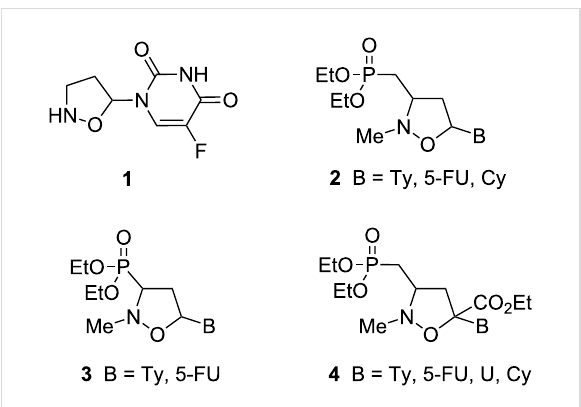
Figure 1: 2’-Oxa-3’-aza-modified nucleosides and 2’-oxa-3’-aza-modi- fied nucleotides.